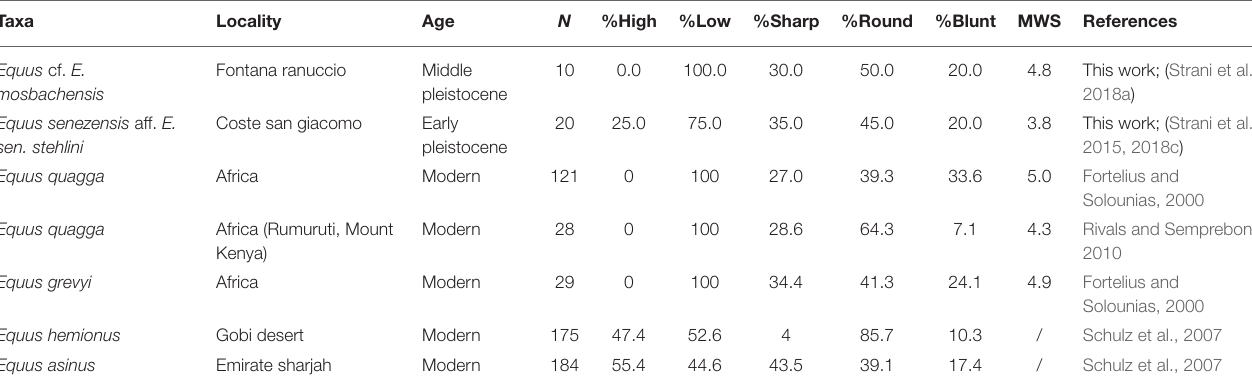
TABLE 1 | Summary of dental mesowear